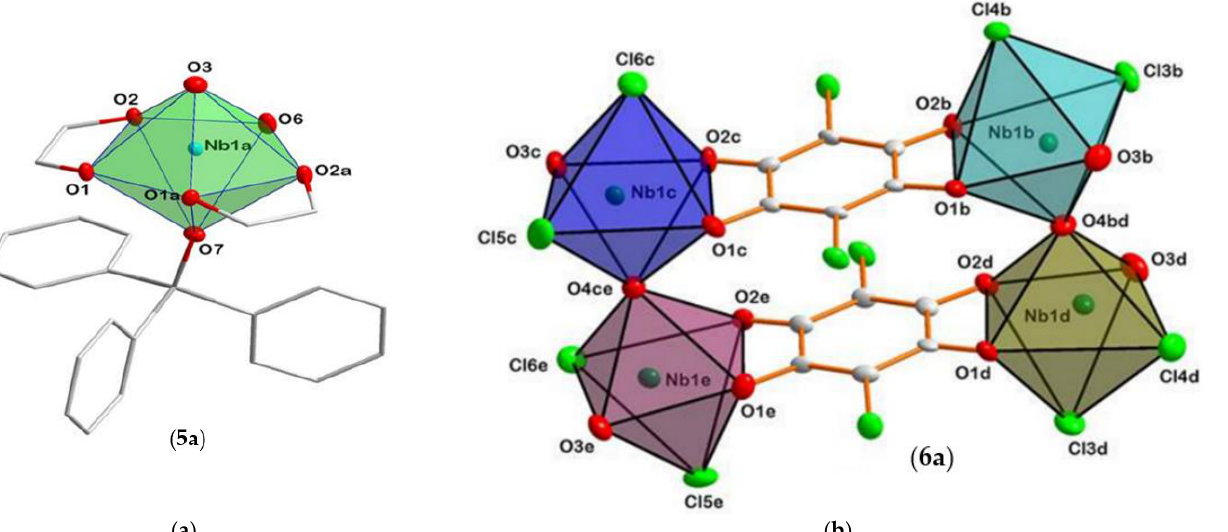
Figure 10. Representation of ( a ) the distorted D 5 h pentagonal bipyramidal coordination polyhedron formed by oxygen donor atoms surrounding the Nb(V) metal centers in cis -[NbO(ca) 2 (H 2 O)OPPh 3 ] − ( 5a ) and ( b ) a regular octahedral coordination polyhedron surrounding the Nb(V) atoms of [Nb 4 O 4 (ca) 2 ( μ 2 -O) 2 Cl 8 ] 4 − ( 6a ). The counter ions, solvates and H-atoms are omitted for clarity. The average Nb=O bond length in complex 6a is 1.716 (8) Å and virtually identical to The ca 2 − ligands in complexes 5a and 6a each form a five-membered ring with